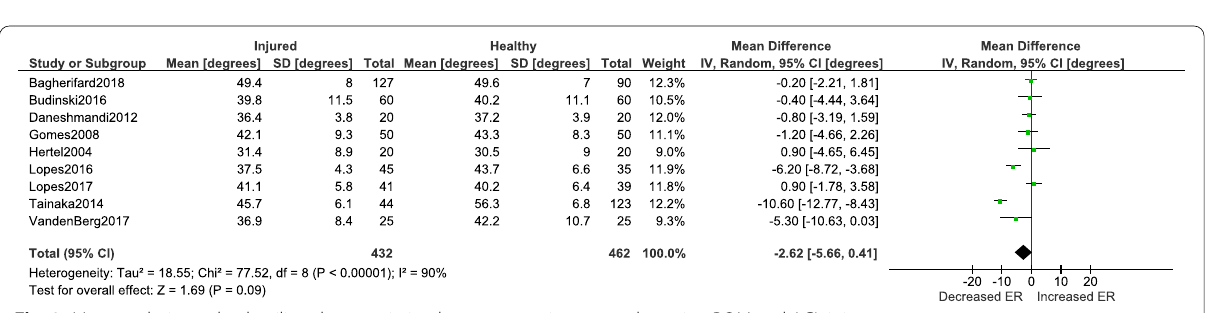
Fig. 3 Meta-analysis results detailing the association between passive external rotation ROM and ACL